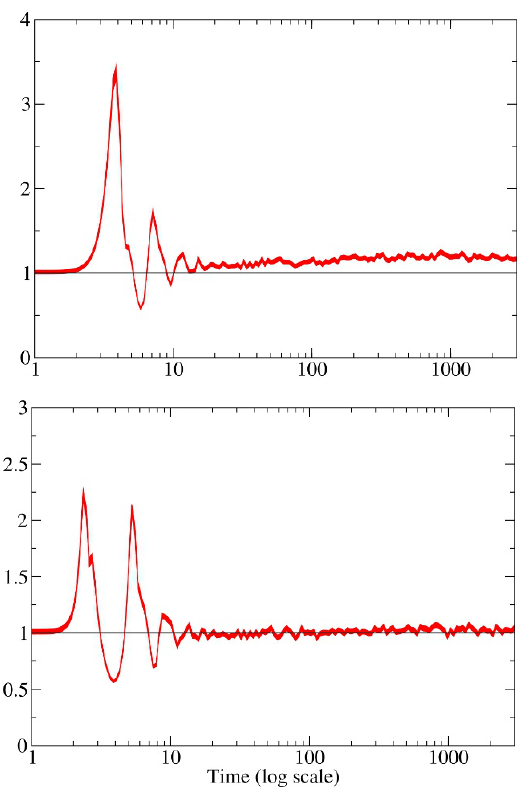
Figure 3 . Time evolution of Y [ X 3 ; X 4 ] (top) and Y [ P 3 ; P 4 ] (bottom) for N = 10 and h = 0 : 3, with vol( E ) (cid:25) 10 4 . The solid line Y = 1 is the TGU